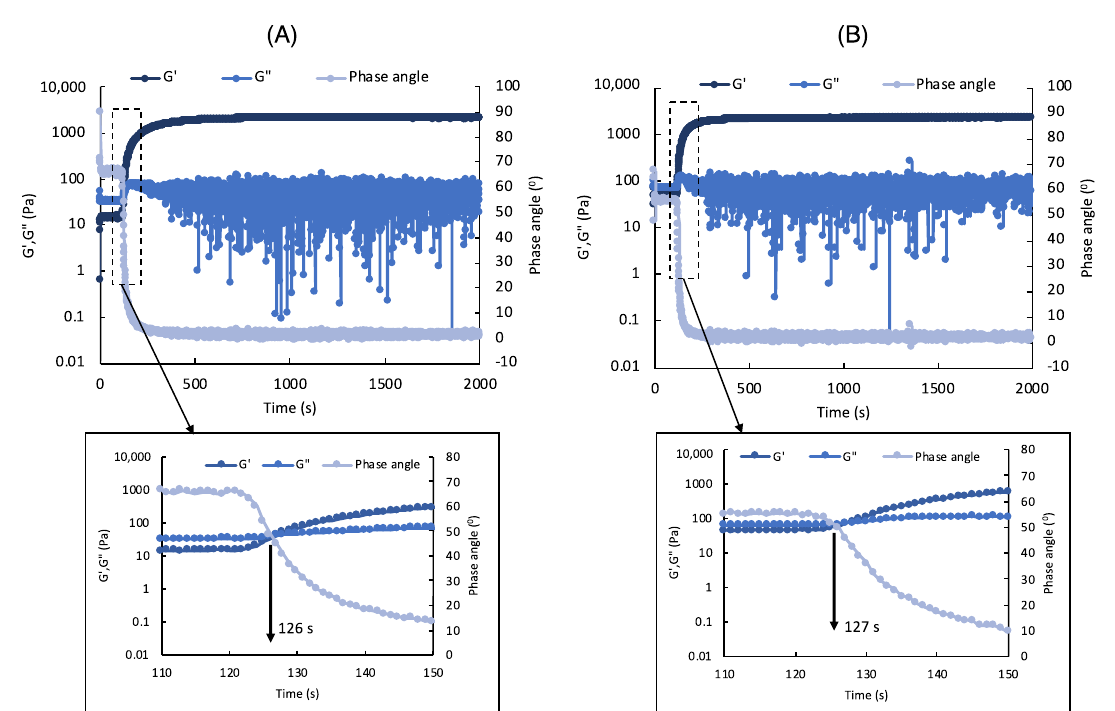
Figure 4. Rheological studies to investigate crosslinking behavior of the neat ( N ) and composite ( C ) inks. ( A – B ) Change in elastic modulus ( G′ ), viscous modulus ( G” ), and phase angle with time for N ( A ) and C ( B ) inks. Light is turned on at 120 s for 20 min. The plots at the bottom show the zoomed in regions indicated by the dotted lines in the top plots.